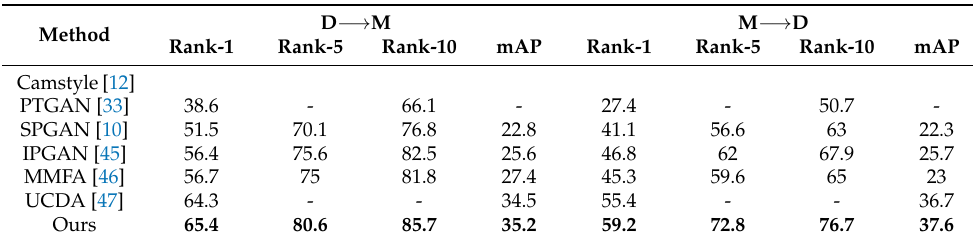
Table 3. Person re-ID performance comparison with the state-of-the-art solutions of style transfer on Market-1501 and DukeMTMC-reID.